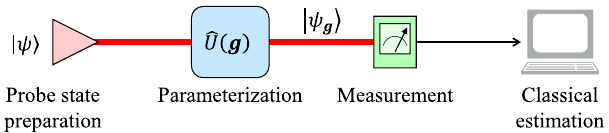
Fig.1|Schematicofthequantumparameterestimation. Ageneralizedquantum parameter estimation process consists of four steps: probe state preparation, parameterization, measurement and classical estimation.